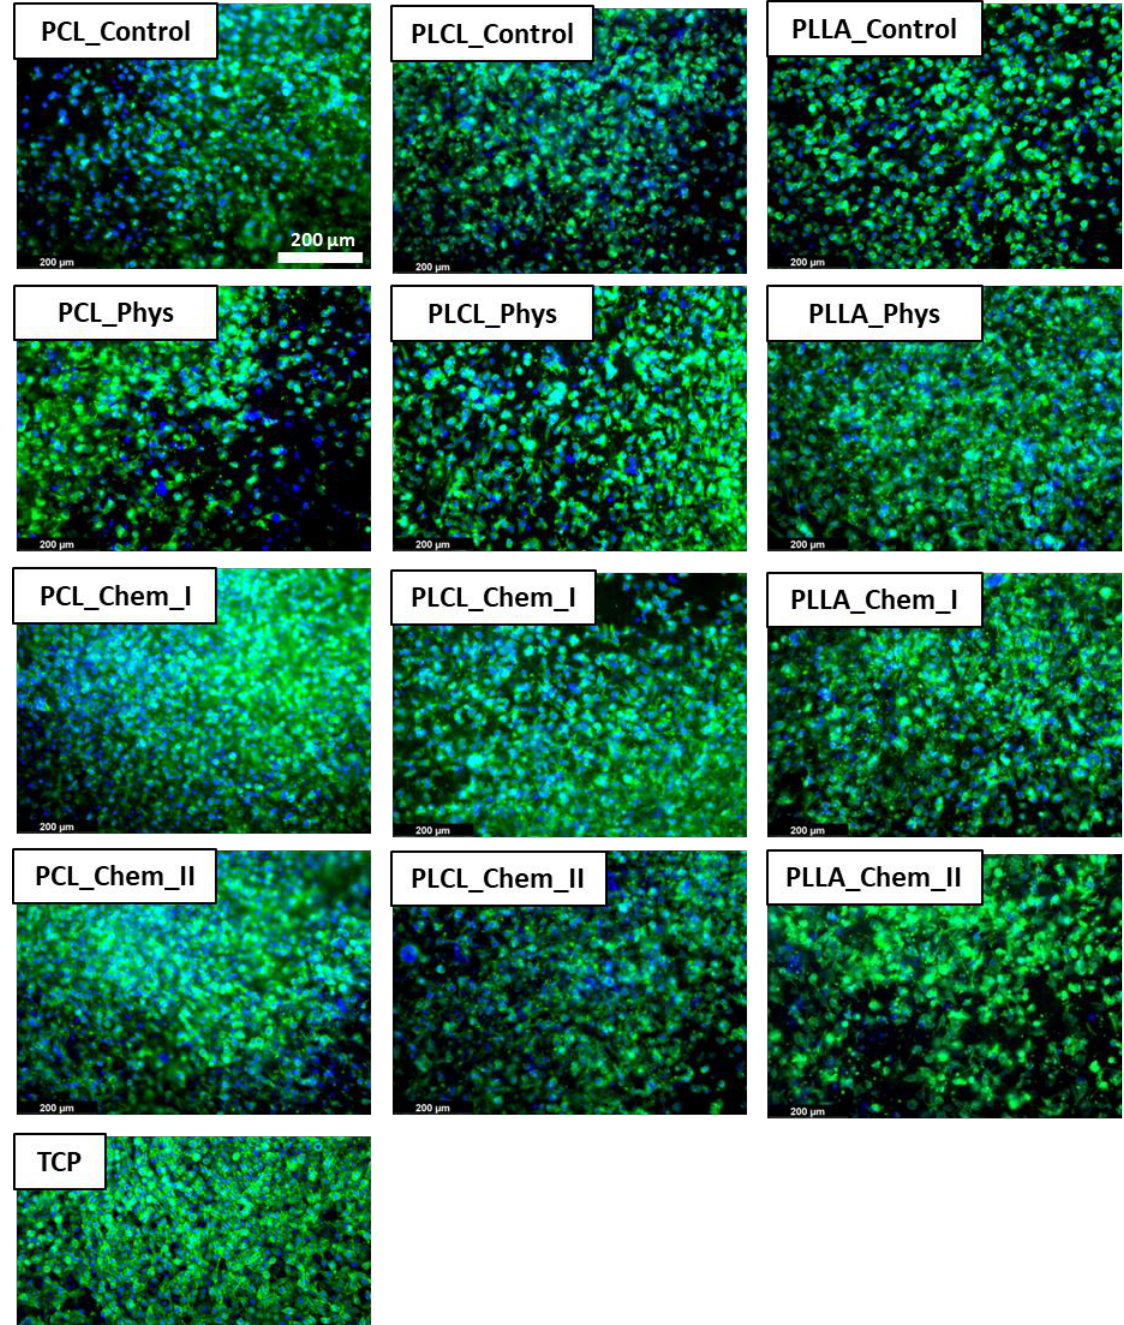
Figure 9. L929 cells cultured on control and gelatin-coated samples for 5 days observed with fluorescence microscopy.